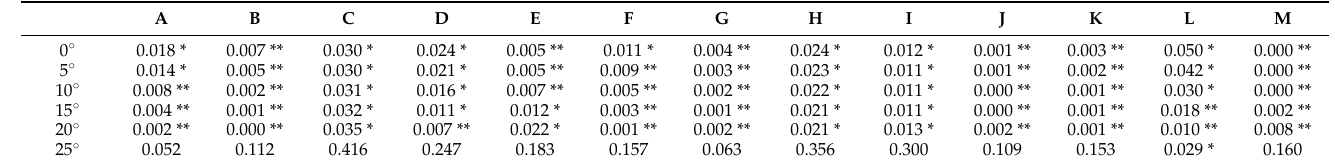
Table 2. Correlations between the RMS wavefront aberration and biological